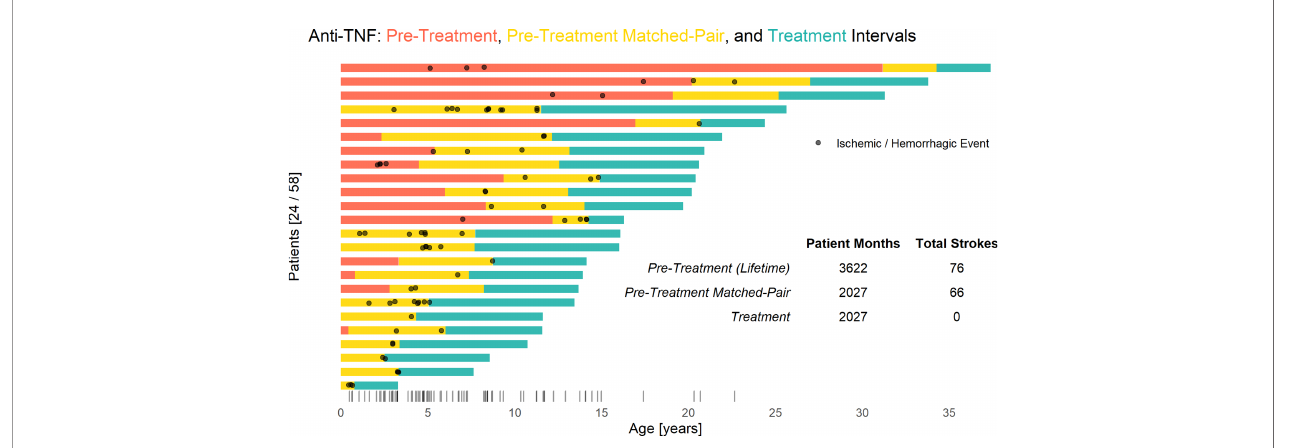
FIGURE 12 | Anti-TNF treatment signi fi cantly reduces stroke risk in DADA2. Each bar represents a single patient ’ s respective anti-TNF treatment intervals and stroke incidence. Prior to starting TNF inhibition (red and yellow) there were a total of 76 strokes in 3,622 cumulative patient-months. No ischemic or hemorrhagic strokes have occurred in 2027 cumulative patient-months during TNF inhibition (blue), whereas 66 strokes were observed in a retrospective matched-pair (yellow) analysis (P < 0.001 by the Exact McNemar test). Overall distribution of stroke incidence by age shown via rug plot.